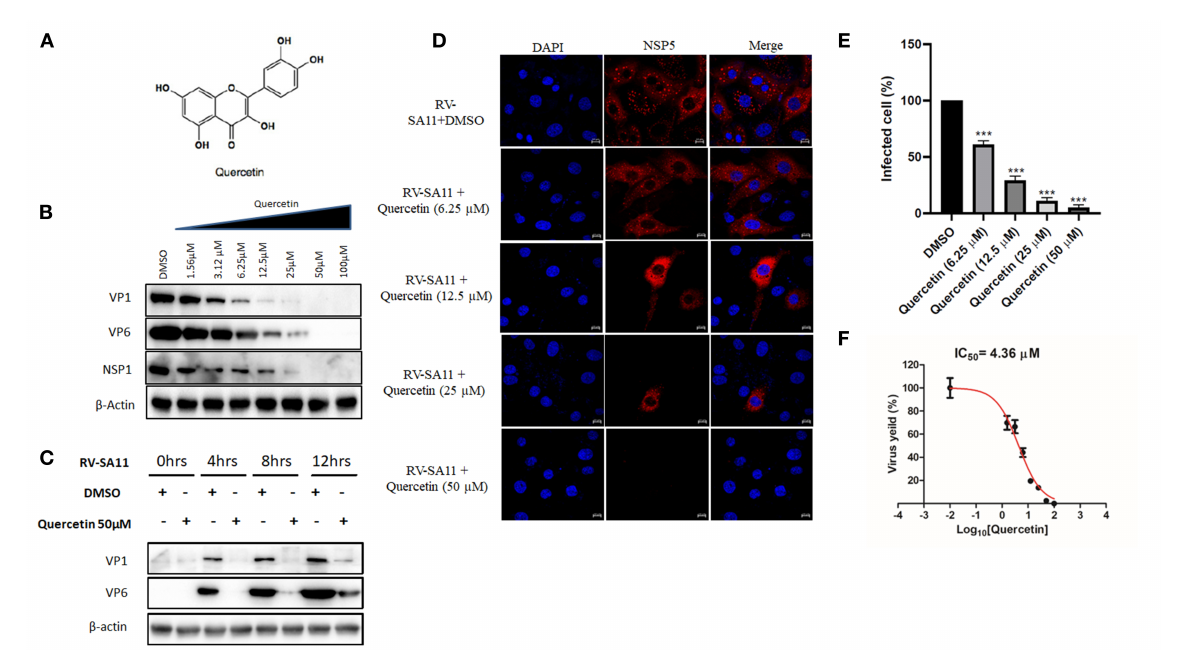
FIGURE1 Quercetin treatment diminishes rotavirus replication in vitro . (A) Chemical structure of quercetin is shown. (B) Western blot is performed from SA11(MOI 3)-infected MA104 cells (12 hpi) treated with DMSO or quercetin (1.56, 3.125, 6.25, 12.5, 25, 50, and 100 µ M) to evaluate the expression of viral proteins VP1 and VP6. β -actin is taken as internal loading control. (C) Protein expression of VP1, VP6, NSP1, and β -actin was checked by immunoblot from SA11-infected MA104 cells treated either DMSO or quercetin (50 µ M) incubated for 0, 4, 8, and 12 hpi, respectively. (D) Immunofluorescence was performed with RV-SA11 (MOI 3)-infected MA104 cells in the presence of DMSO and quercetin (6.25, 12.5, 25, and 50 µ M). At 8 hpi, cells were fixed and permeabilized followed by staining with anti-NSP5 antibody. Secondary staining was done with rhodamine-labeled anti-rabbit antibody. DAPI was used for mounting. Finally, cells were visualized with confocal microscope (63 × oil immersion); scale bar 10 µ m. (E) Minimum of 100 cells from different fields from each experimental slide were selected randomly and analyzed for the quantification of viroplasm-positive cells. The data were represented as mean viroplasm-positive cells (%) ± SD of three experimental replicates. (F) Plaque assay was performed from RV-SA11 (MOI 1)-infected MA104 cell treated with graded concentration of quercetin (1.56, 3.125, 6.25, 12.5, 25, 50, and 100 µ M) for 24 hpi to measure IC 50. Each bar represents mean ± SD of three independent experiments (Unpaired student’s t-test, *** p <